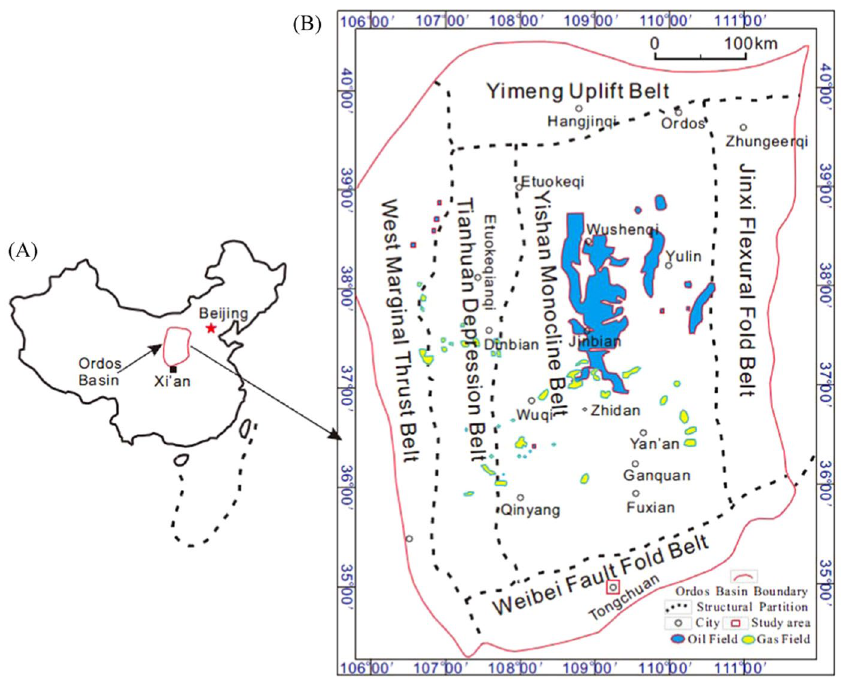
Figure 1. Ordos Basin structure and location of study area. ( A ) Map showing the Ordos Basin in China. ( B ) Tectonic map of Ordos Basin, modified after Lei (2015) 32 ; the study area in the south part of the Weibei uplift is outlined by a red box. The source of the map is the Geological Society of America bulletin, Vol. 99(4), April, 2015. Permission for the map was obtained from an Open Access license with license number 4026530233979. The figure was created using the Chinese version of CorelDraw Graphic Suite X8.